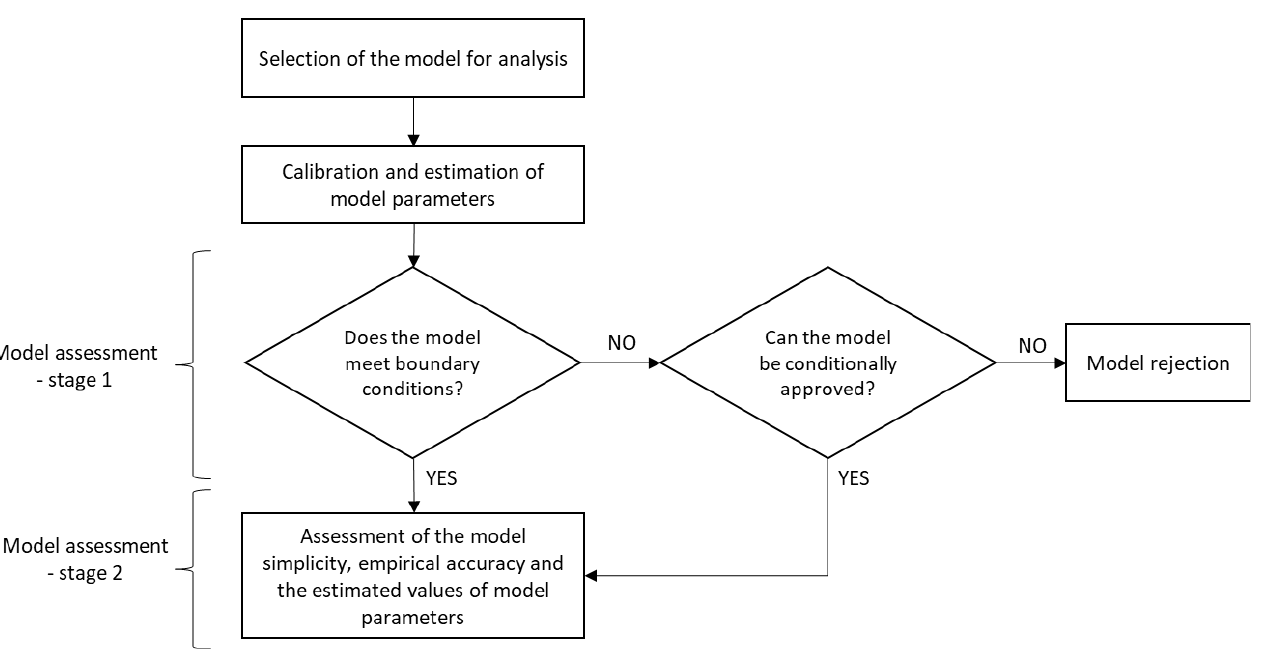
Figure 5. Procedure for model assessment.